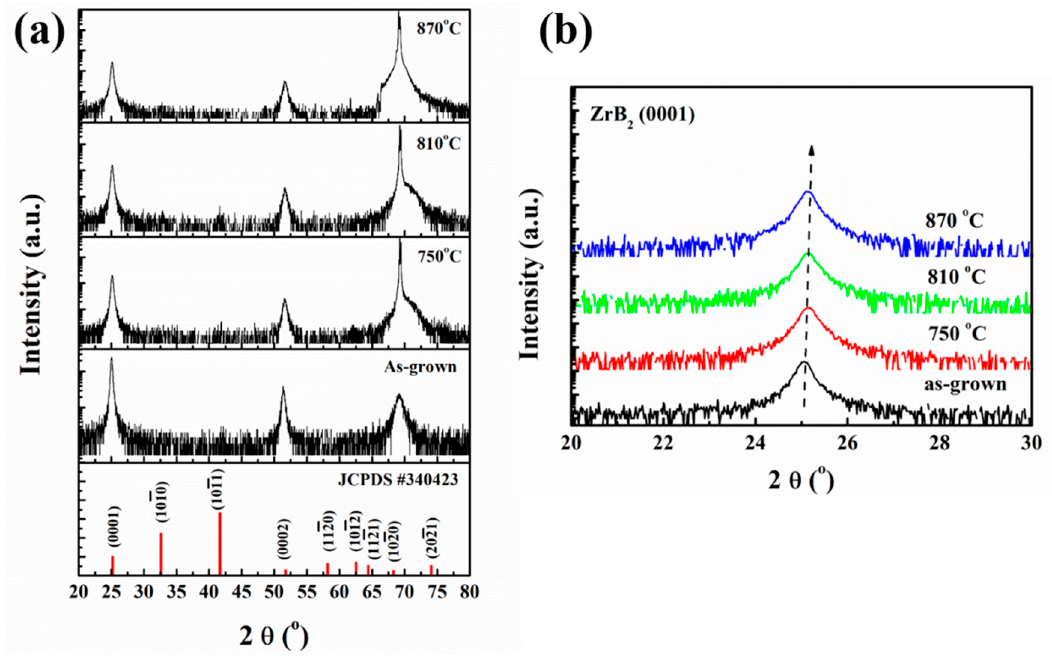
Figure 1. All ZrB 2 films deposited on Si(100) as-grown and annealed at various temperatures. ( a ) θ –2 θ X-ray diffraction (XRD) pattern of all ZrB 2 films and JCPDS#340423; ( b ) XRD pattern for the (0001) peak of all ZrB 2 films in the 2 θ range of ~22° to 30°.